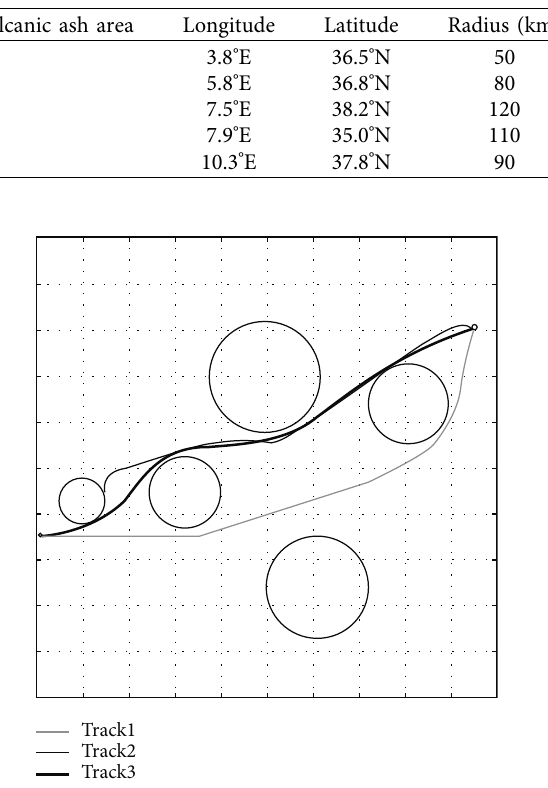
Table 4: Latitude and longitude coordinates and radius of the volcanic ash canter.